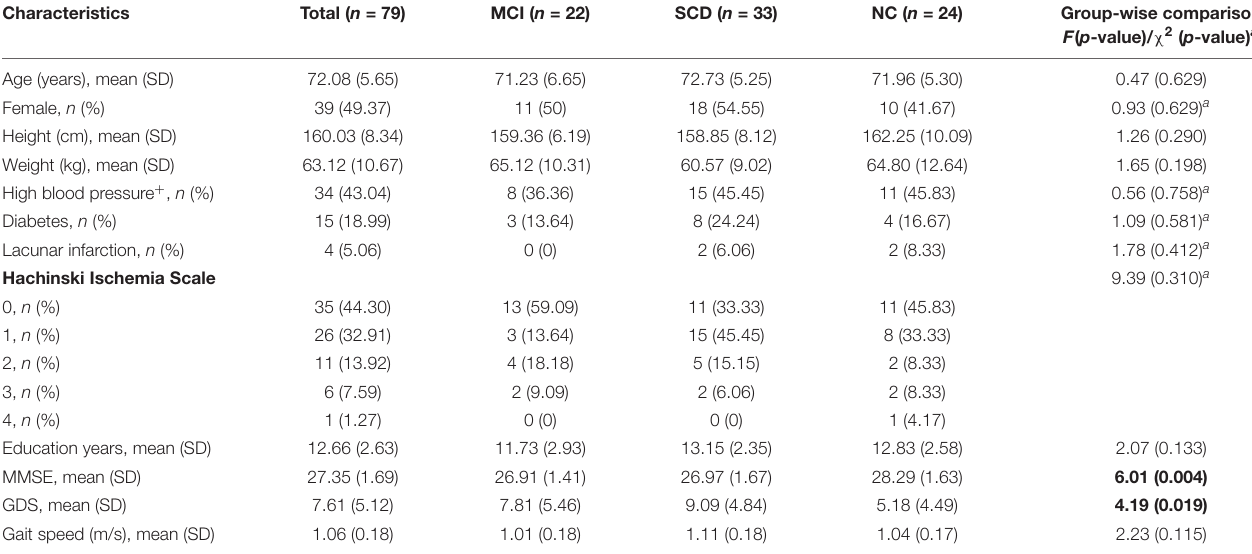
TABLE 1 | Baseline characteristics. Characteristics